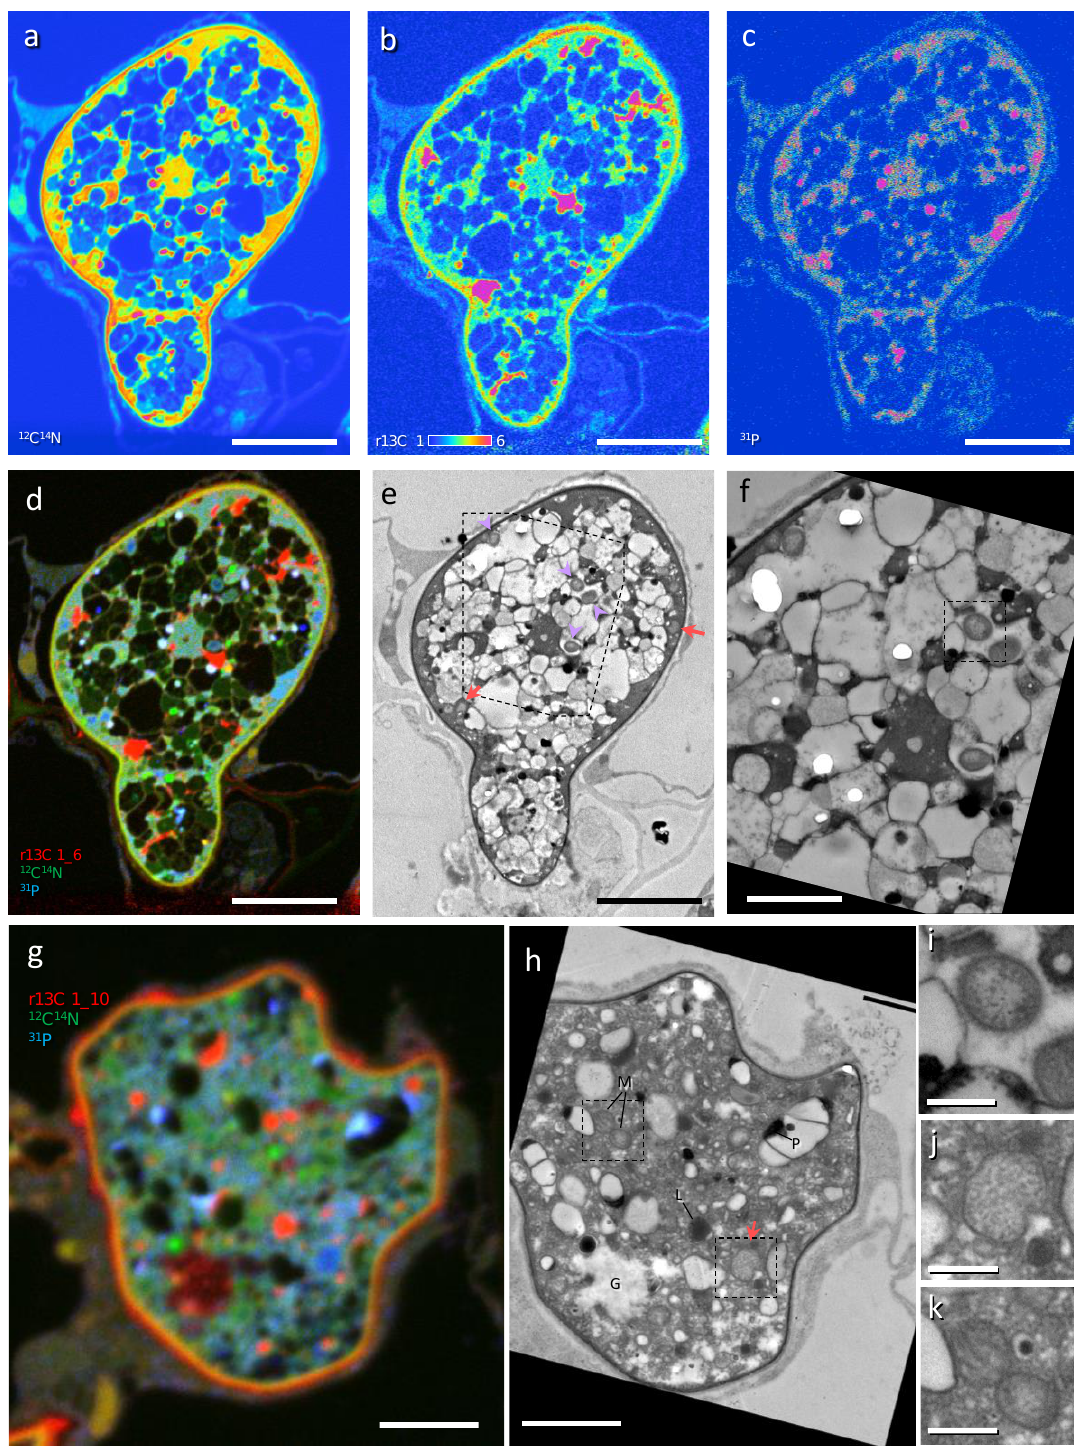
Figure 2. Correlative imaging by transmission electron microscopy (TEM) and NanoSIMS-50 of a 13 CO 2 labelled Allium cepa root colonized with Gigaspora margarita . ( a ) 12 C 14 N. ( b ) 13 C/ 12 C × 100 (r13C). ( c ) 31 P. ( d , g ) Overlay images of r13C (red), 12 C 14 N (green), and 31 P (blue). ( e , f , h – k ) Corresponding TEM of ( a – d , g ). G, glycogen; M, mitochondrion; L, lipid body; P, polyphosphate. Arrows, Candidatus Moeniiplasma glomeromycotorum; arrowheads, Candidatus Glomeribacter gigasporarum. Dashed squares in ( e , f , h ) show areas corresponding to ( i , j , k ), respectively. Bars: ( a – e ), 5 μm; ( f – h ) , 2 μm; ( i – k ), 0.5 μm.